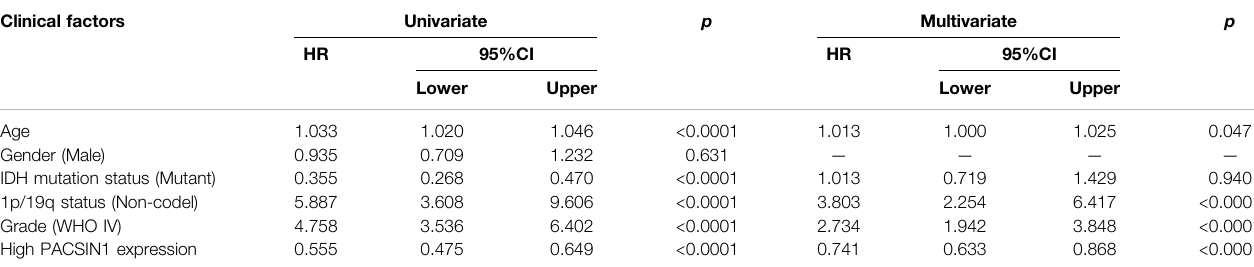
TABLE 1 | Univariate and multivariate Cox analysis of PACSIN1 expression and clinical indicators in CGGA dataset. Clinical